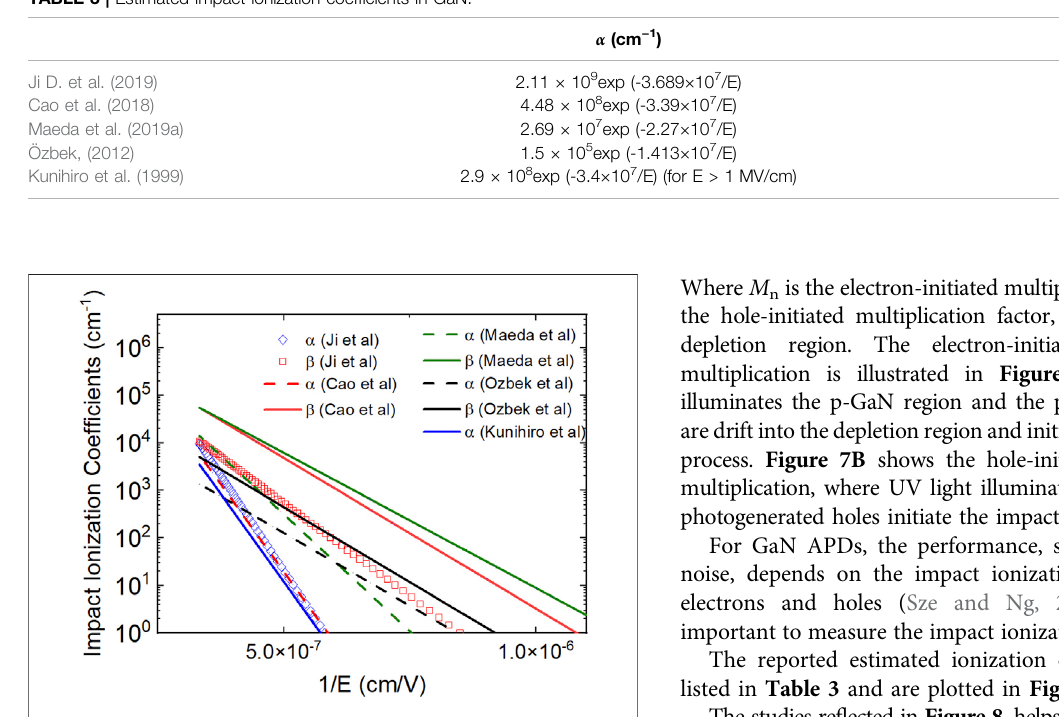
FIGURE 8 | Reported impact ionization coef fi cients of electrons ( α ) and holes ( β ) in GaN (Kunihiro et al., 1999; Özbek, 2012; Ji D. et al., 2019; Maeda et al., 2019a; Cao et al.,